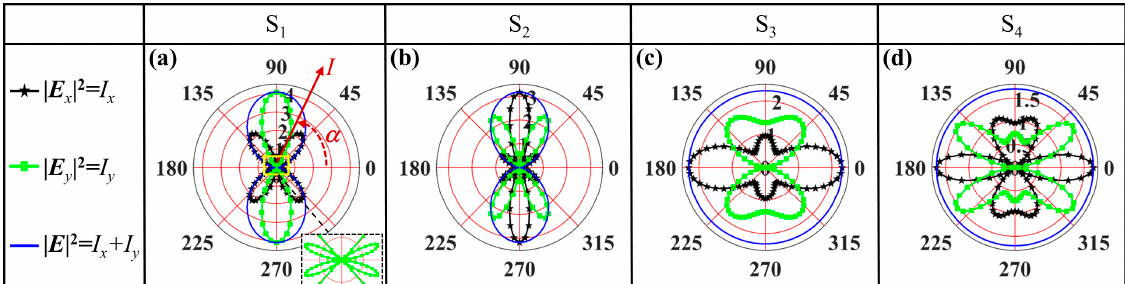
Figure 4. The curves of the intensity of superimposed VBs versus azimuthal angle α , ( a – d ) show the theoretical curves of the intensities | E x | 2 , | E y | 2 and | E x | 2 + | E y | 2 with α for samples S 1 –S 4 , respec- tively.